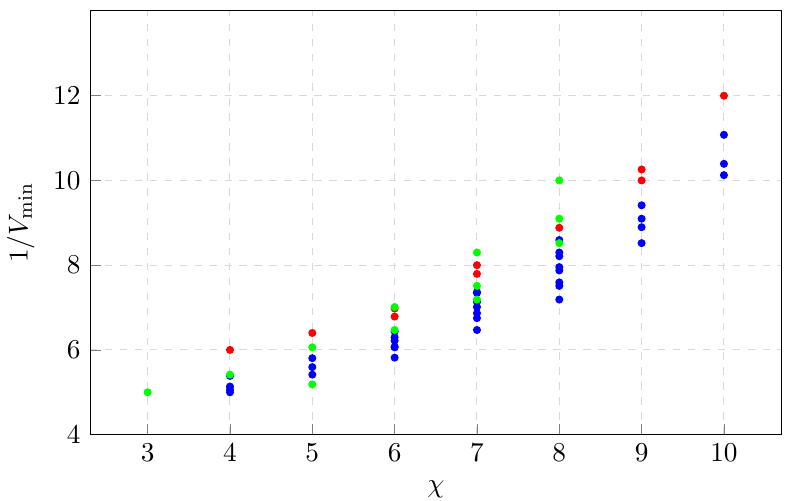
Figure 5. The reciprocal of minimized volumes against the Euler numbers. Here, the points that live much closer to the upper bound in the diagram are labelled